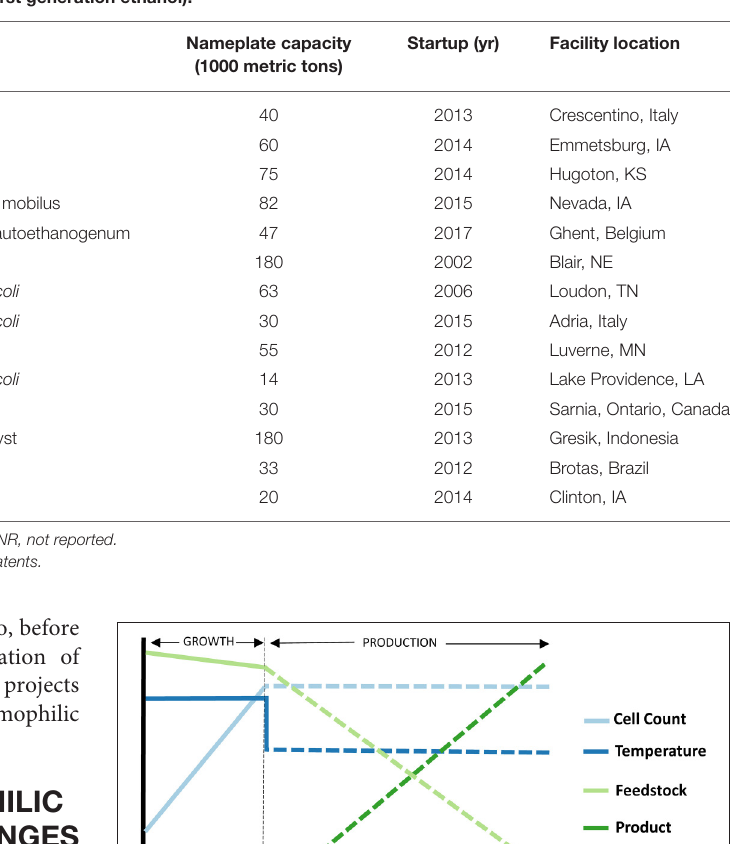
TABLE 4 | Commercial scale biochemical production (excluding 1st generation ethanol).